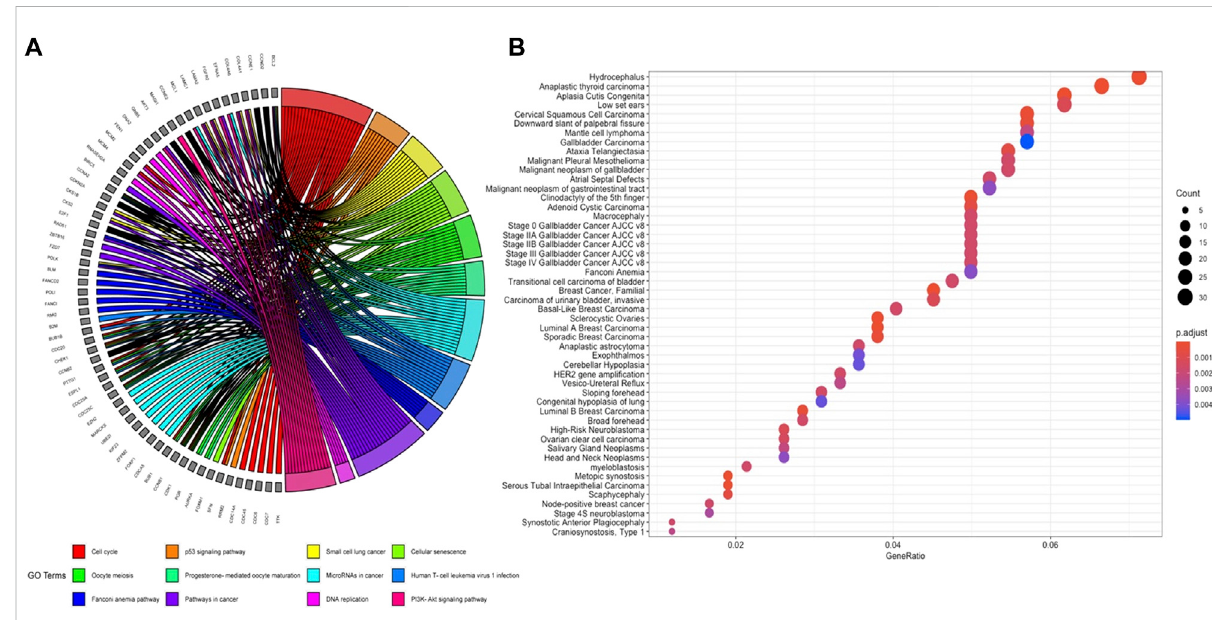
FIGURE 2 (A) GOChord plot of signi fi cantly enriched KEGG pathways. (B) Signi fi cantly associated diseases of common DEGs in ovarian